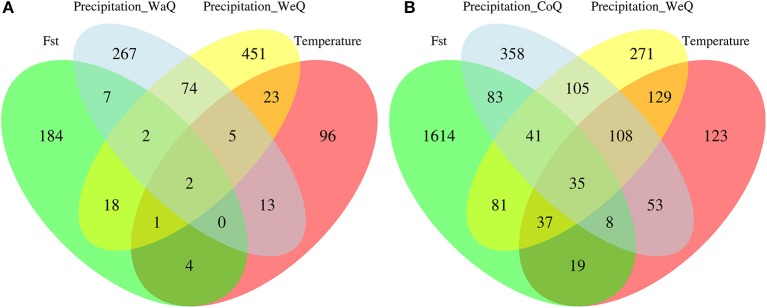
Venn diagram showing the intersection of sequences (contigs) containing candidate SNPs for I. cavalcantei
(A) and I. maurandioides
(B). Putative adaptive loci were identified using environmental association tests and genome scans (Fst outlier tests), and the environmental variables used differed between species (I. cavalcantei: Minimum Temperature of Coldest Month, Precipitation of Warmest Quarter and Precipitation of Wettest Quarter; I. maurandioides: Minimum Temperature of Coldest Month, Precipitation of Coldest Quarter and Precipitation of Wettest Quarter).